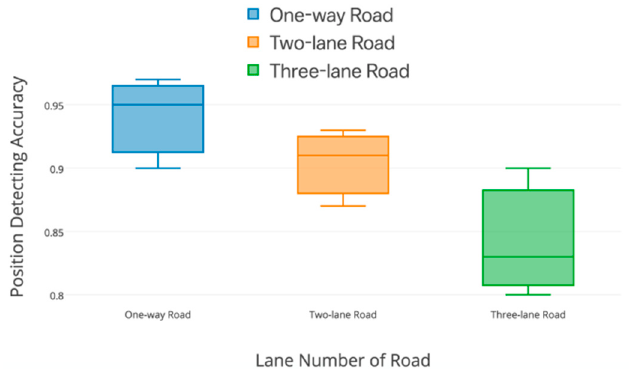
Figure 21. Relative position detection of different roads.